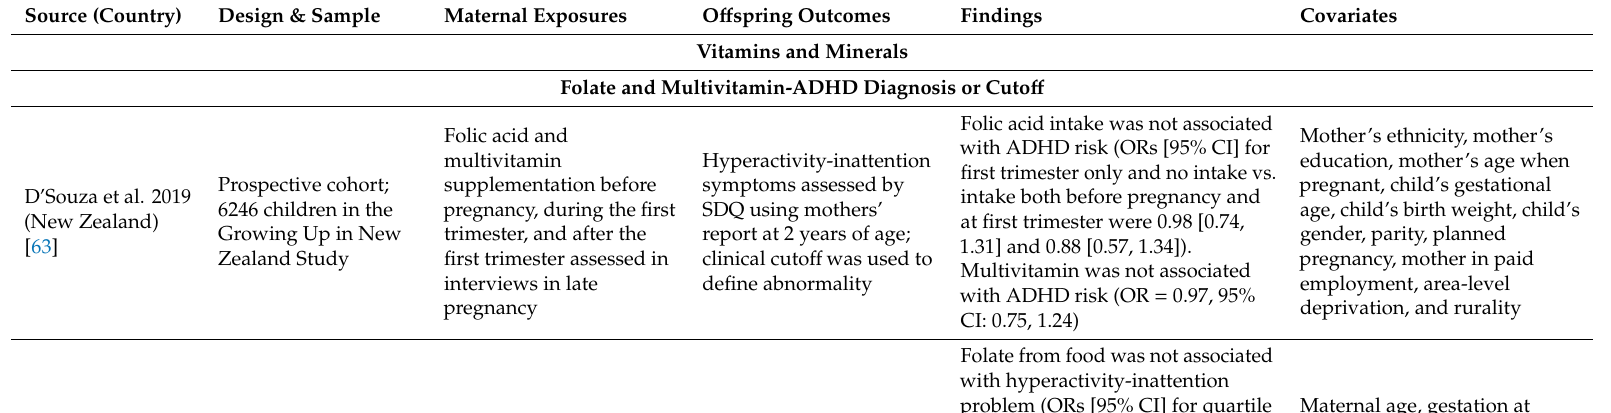
Table 2. Studies on maternal nutrition and o ff spring ADHD risk or